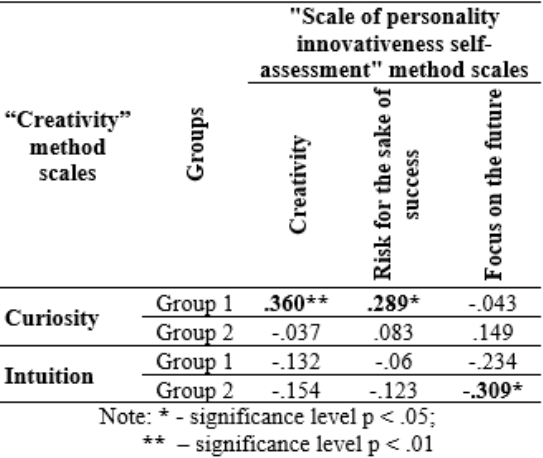
Table 4. The results of correlation anal - ysis by the “Creativity” method by N. Vish - nyakova and “Scale of personality innovative - ness self-assessment” (N. M. Lebedeva, A.